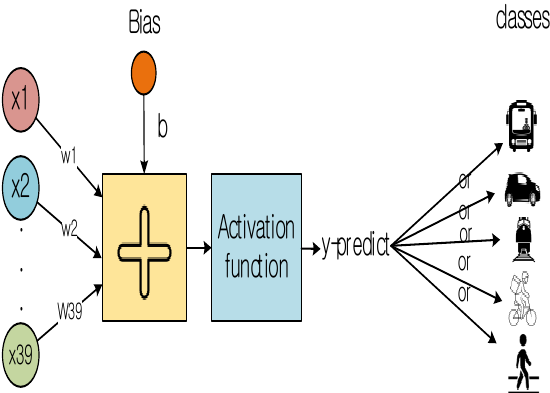
Figure 4 . A simple diagram of using Logistic Regression for classifying transportation